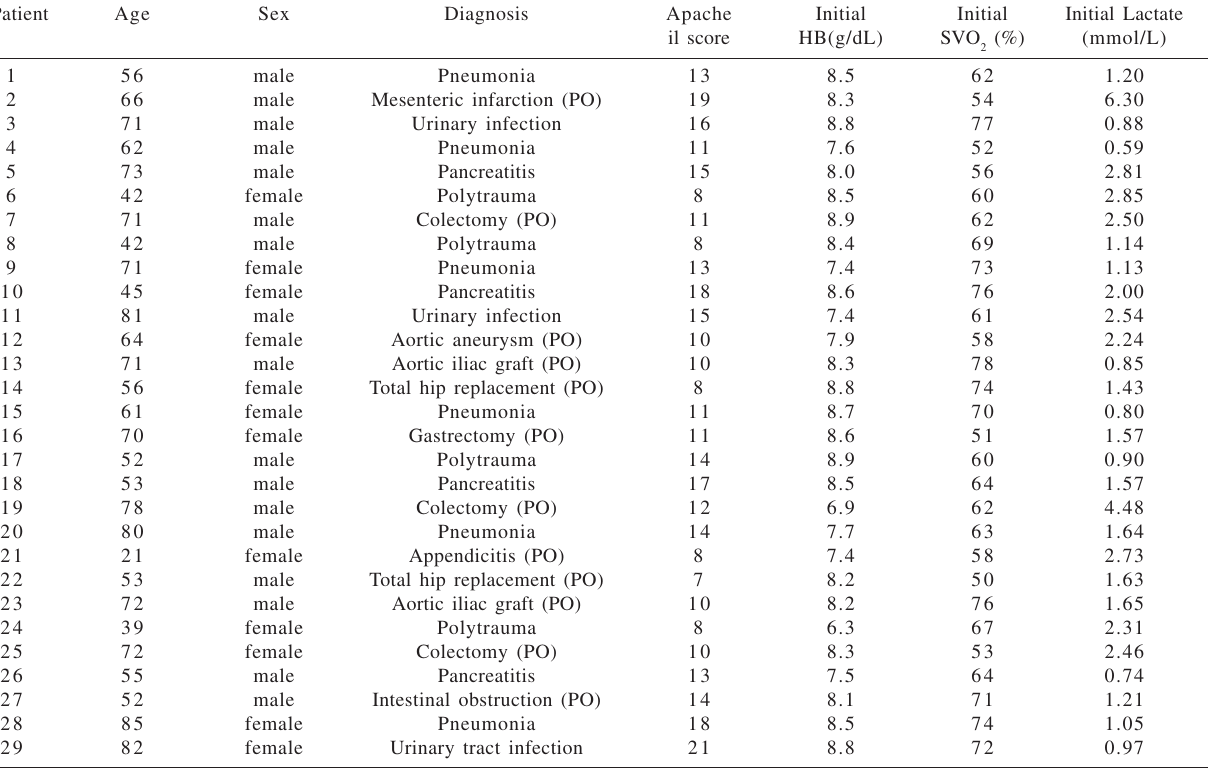
Table 1 - General features of the patients